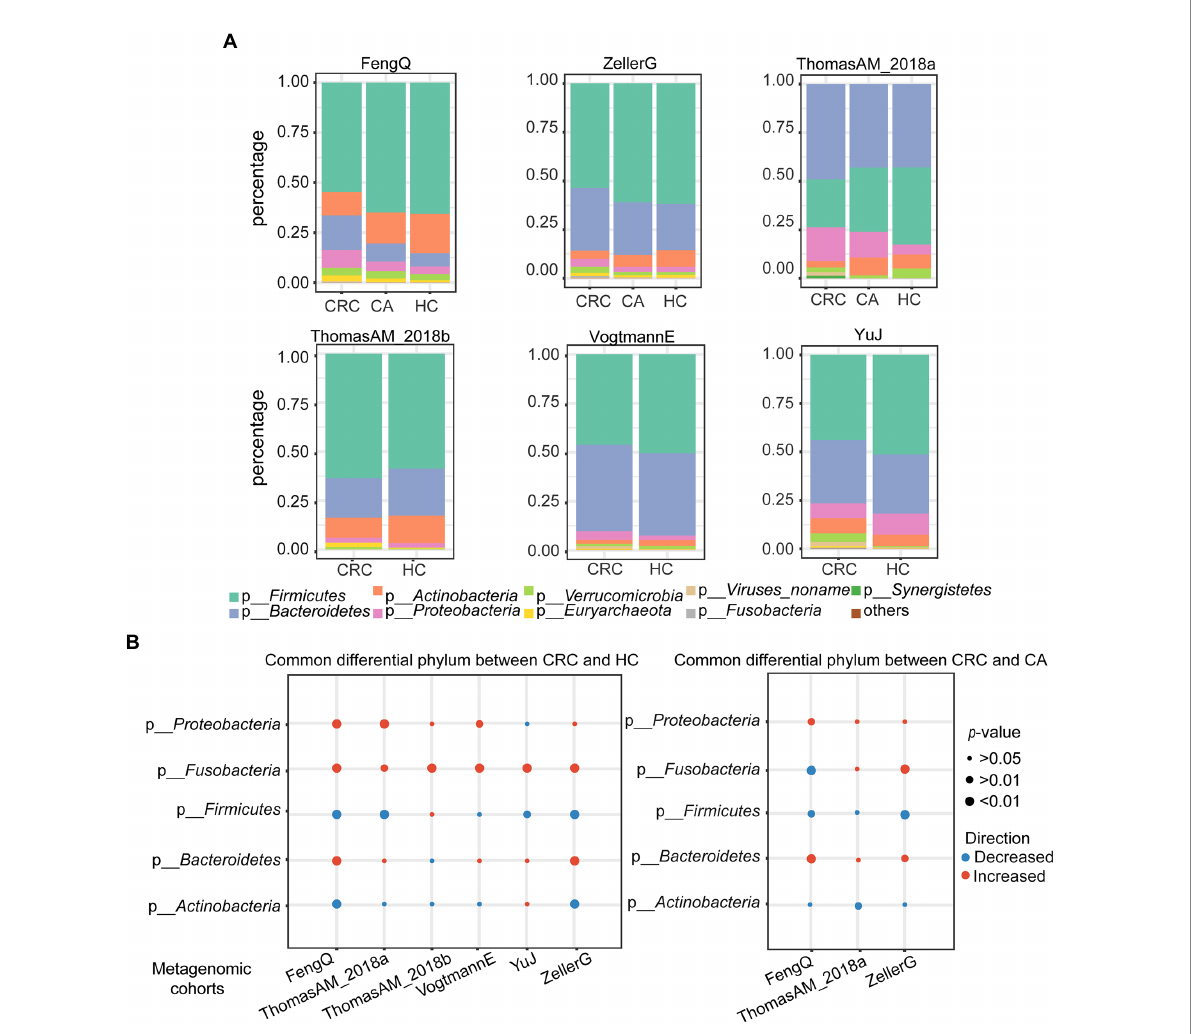
FIGURE 2 Principal and significantly differential microbes at phylum level in six metagenomic sequencing datasets. (A) Relative proportions of top eight principal phyla in HC, CA, and CRC. (B) Alterations of top five phyla between CRC and HC (left) or CA (right). Red and blue indicated phyla were increased and decreased in the CRC group, respectively. p -value was calculated by Wilcoxon rank-sum